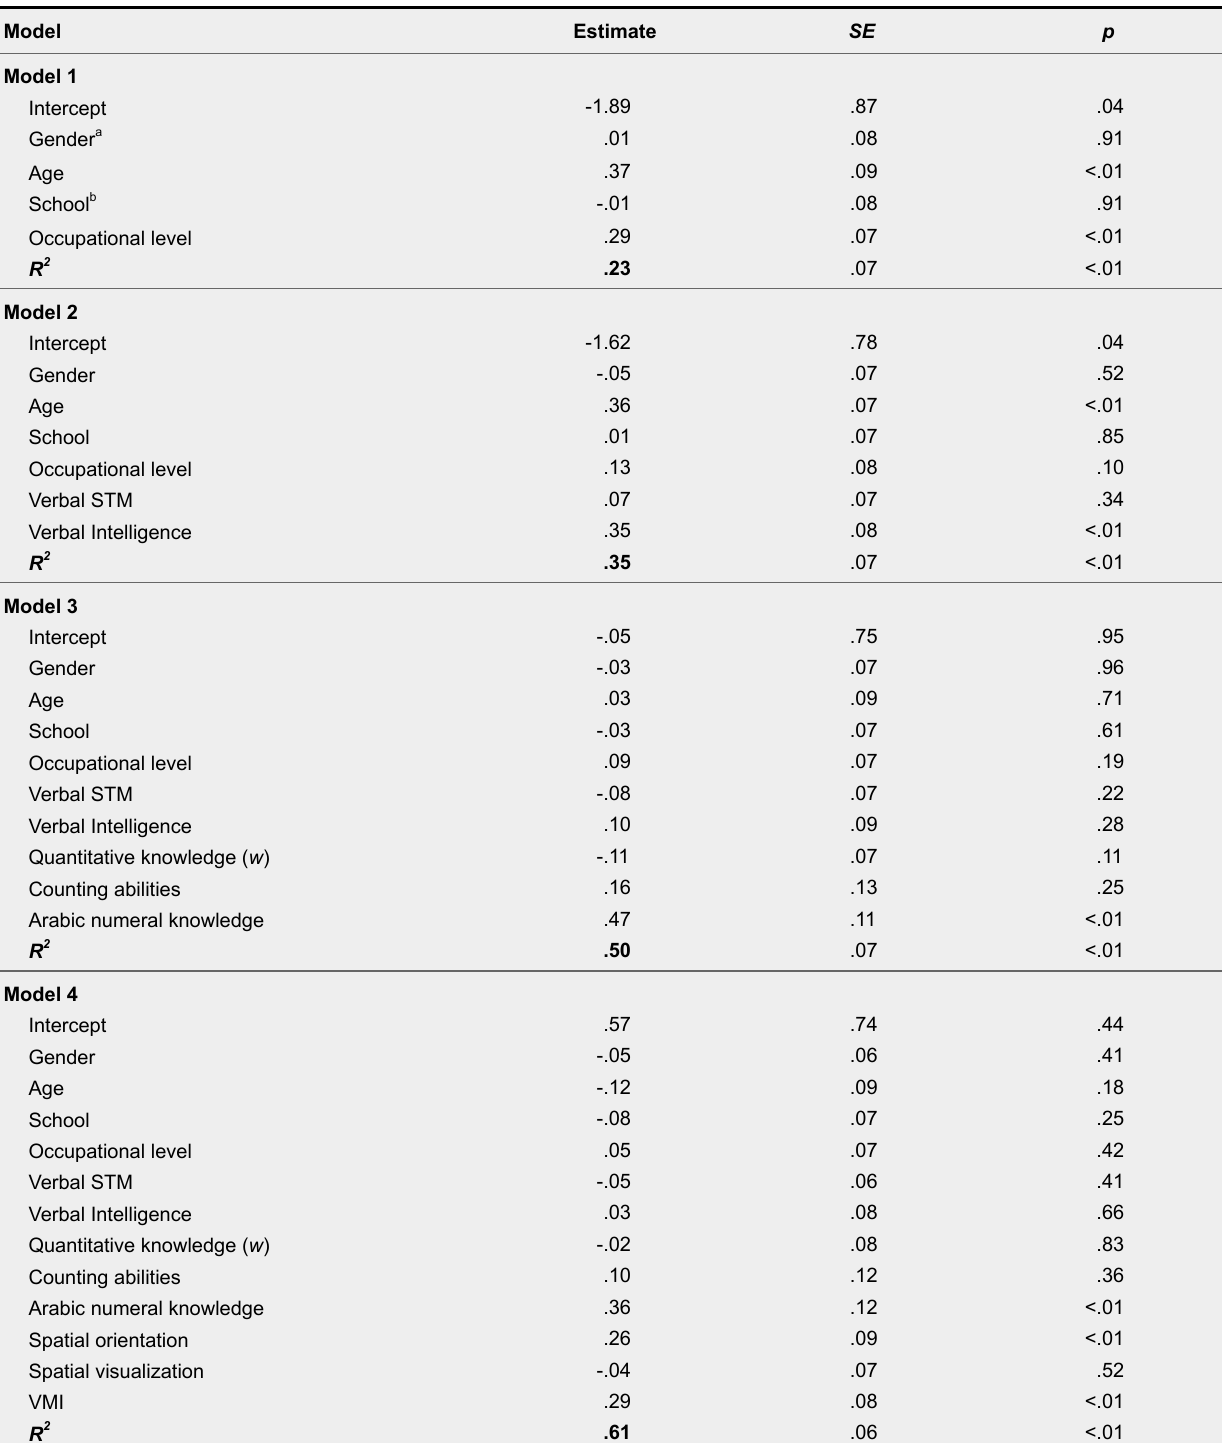
Standardized Parameter Estimates of the Different Models Predicting Performance in